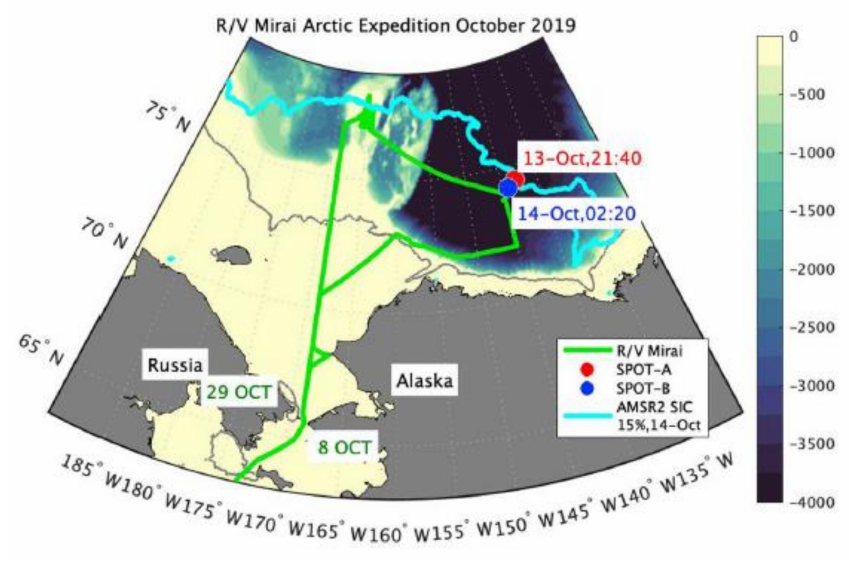
Figure 20. Positions of the deployed “spotter” buoys to measure wave characteristics